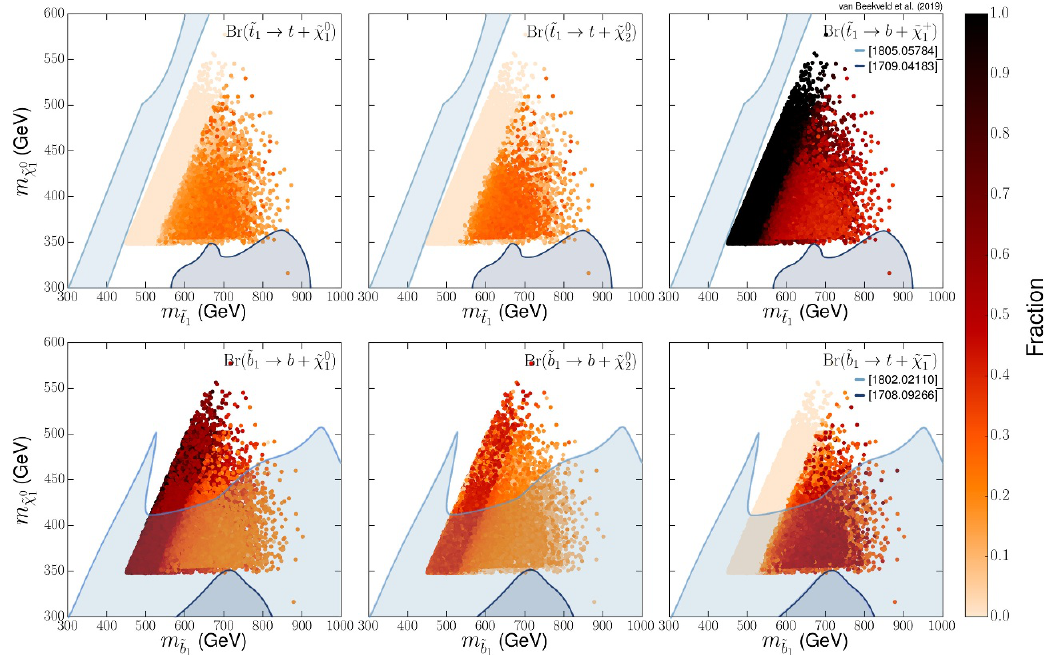
JHEP01(2020)147 Figure 13 . Branching ratios of ~ t 1 and ~ b 1 for the allowed pMSSM-GUT spectra with (cid:1) BG < 200, where spectra with lower values for (cid:1) HS lie on top of those with higher values. The top (bottom) BG row shows m ~ ( m ~ ) against m in GeV, and the relevant decay process is indicated in the upper ~ (cid:31) 0 1 t 1 b 1 right corner of each plot. The two shaded areas in the plots on the top panel show the exclusion limits of ref. [148] (light blue), where Br(~ t 1 ! t ~ (cid:31) 0 ) = 100% is assumed, and ref. [149] (dark blue), 1 where a mixed decay scenario is assumed. The two shaded areas in the plots of the bottom panel show the exclusion limits of ref. [150] (light blue), where Br(~ b 1 ! b ~ (cid:31) 0 ) = 100% is assumed, and 1 ref. [151] (dark blue), where mixed decay scenarios are